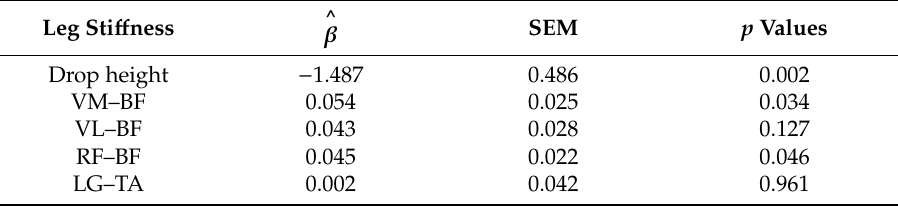
Table 1. Leg sti ff ness linear mixed model coactivation estimates.